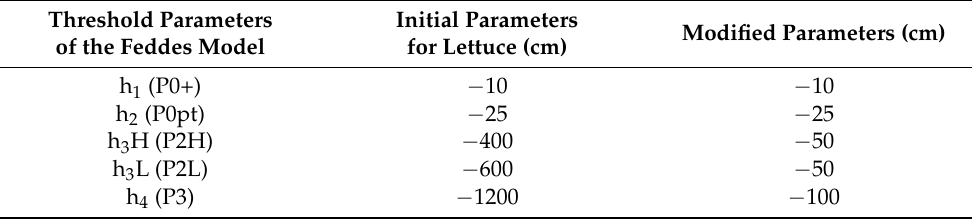
Table 2. Threshold parameters of the Feddes model used in the HYDRUS simulations for spinach. Threshold